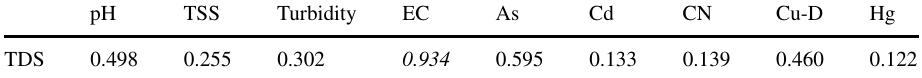
of statistically input parameters on